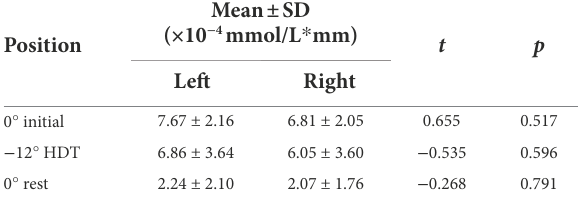
TABLE 3 Comparison of HbO concentrations in the left and right PFC in different positions.